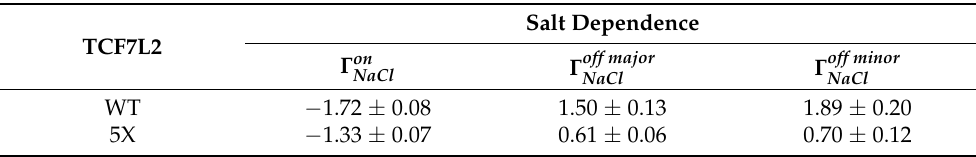
Table 3. Ionic strength dependence of the interaction between β -catenin and the WT TCF7L2 and 5X